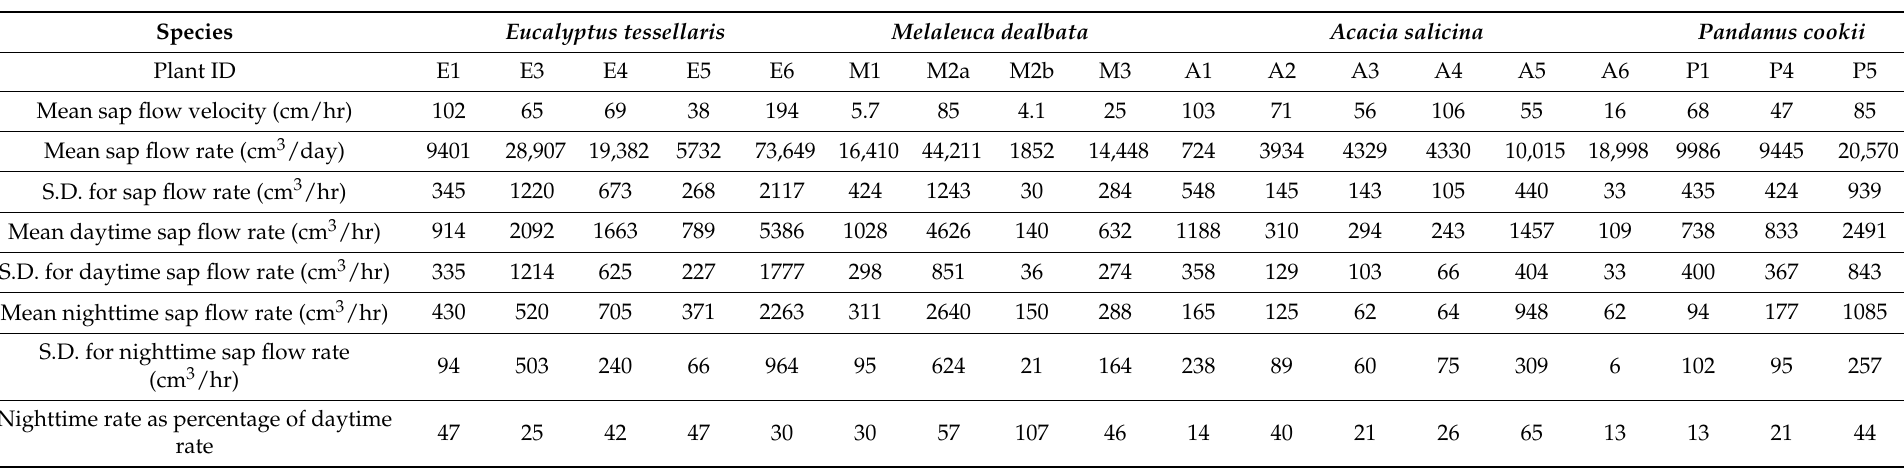
Table 2. Sap flow rates for each